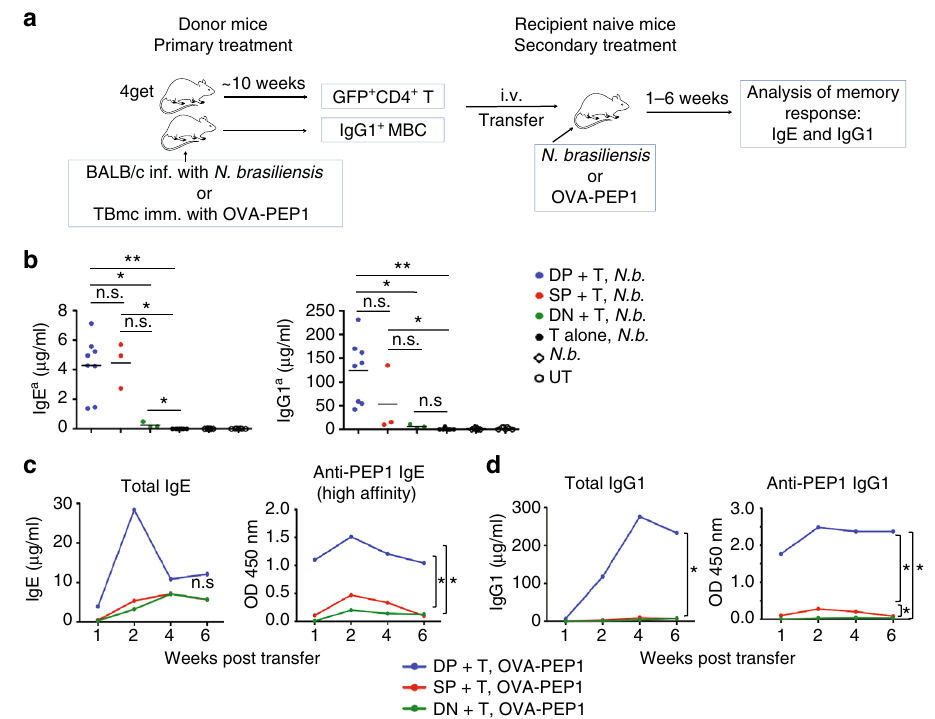
Fig. 2 CD73 + CD80 + IgG1 MBC give rise to high-af fi nity IgE. a Diagram of adoptive transfer experiments to evaluate IgE production from IgG1 MBC subsets (i.v.: intravenously). b Donor-derived IgE a and IgG1 a production in CB17 IgH b recipient mice transferred with IgG1 + MBC (DP, SP and DN) and CD4 memory T cells (T) from N.brasiliensis (N.b.) infected mice, and subsequently infected with N.b . IgE a and IgG1 a serum levels were determined at 2 weeks after transfer and infection. The data shows average of n = 8 for DP + T, n = 3 for SP + T, n = 3 for DN + T, or n = 7 for T alone, n = 7 for N.b . and n = 7 for untreated (UT) groups. The samples were pooled from three independent experiments. Statistical analysis was performed using Mann – Whitney – Wilcoxon U -test. * P < 0.05, ** P < 0.01; n.s., not signi fi cant ( P > 0.05). c , d Kinetics of the production of total and PEP1-speci fi c IgE c and IgG1 d in serum of Rag1 KO mice that were transferred with IgG1 MBC (DP, SP and DN) and CD4 memory T cells (T) from OVA-PEP1 immunised TBmc mice, and were subsequently immunised with OVA-PEP1. The data for each time point was obtained with pooled serum from 4 (DP and SP) and 3 (DN) recipient mice per group. The serum was diluted 500-fold to measure PEP1-speci fi c IgG1, and 100-fold to measure PEP1-speci fi c IgE. Non-parametric Kruskal – Wallis rank-sum test was used to calculate P value. * P < 0.05; n.s., not signi fi cant ( P > 0.05). The data are representative of three independent experiments